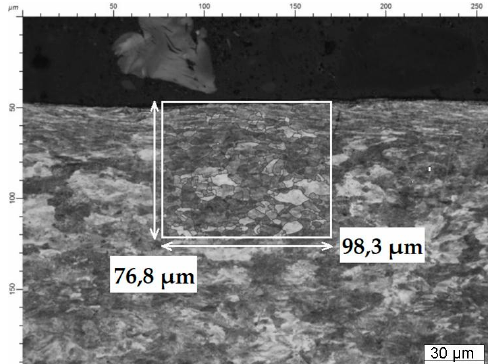
Figure 4. Panoramic image of wire with circled grains in Thixomet PRO software (the rectangle of analysis).